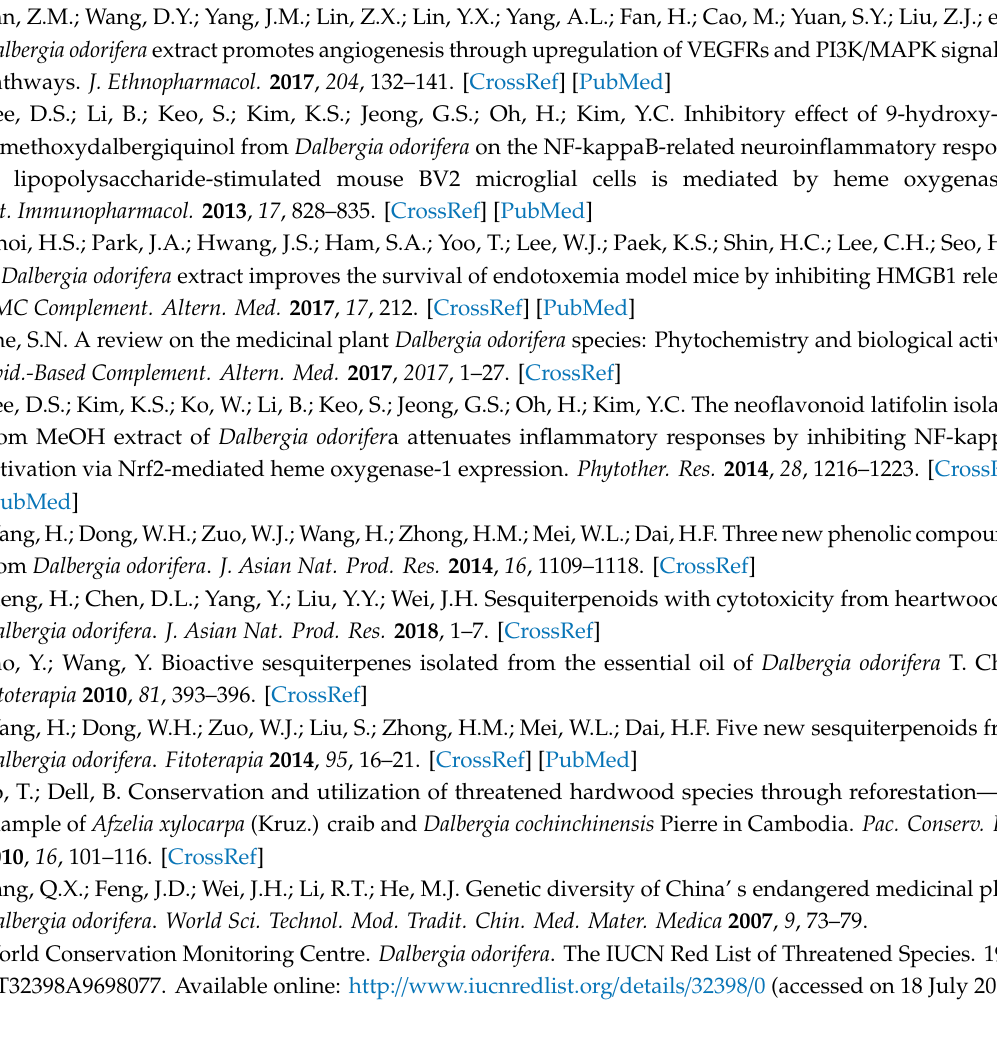
Figure S1: Principal coordinate analysis (PCoA) based on pairwise Nei’s unbiased genetic distance. Table S1: Information of 251 Dalbergia odorifera germplasm, Table S2: Details of 19 microsatellite markers, Table S3: The overall Ewens–Watterson test for neutrality across 19 microsatellite loci in Dalbergia odorifera germplasm, Table S4: Table S5: Summary on genetic diversity statistics of Dalbergia odorifera core collection, Table S6: Pairwise genetic di ff erentiation index (Fst) values in core